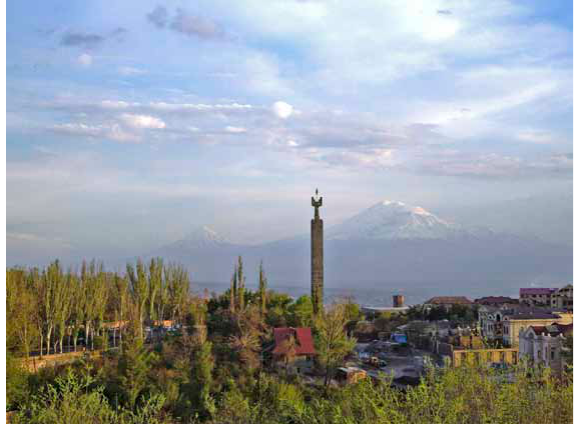
fig. 15. Panorama of Yerevan with ararat. a. ayvazyan